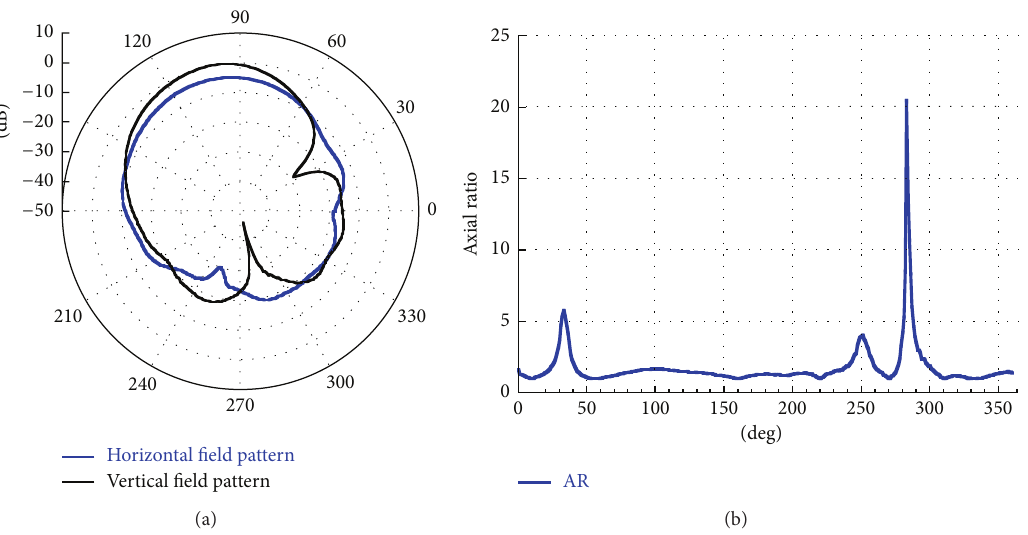
Figure 21: Circular polarization (a) field pattern comparison. (b) Axial